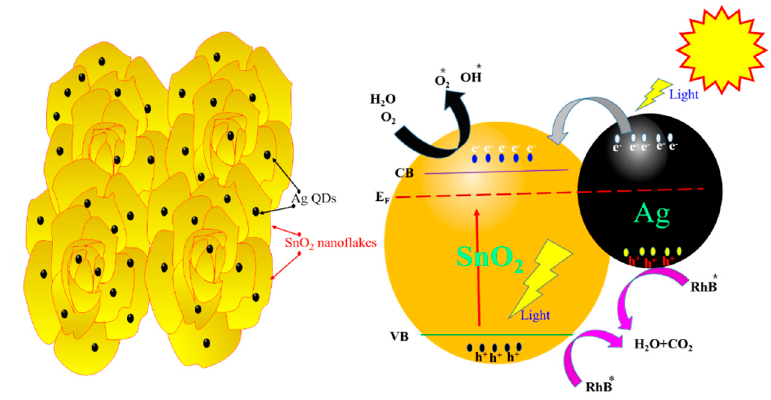
Figure 10. Schematic representation of the photocatalytic reaction progression and charge transfer of Ag QDs/SnO 2 nanoflakes under light irradiation.